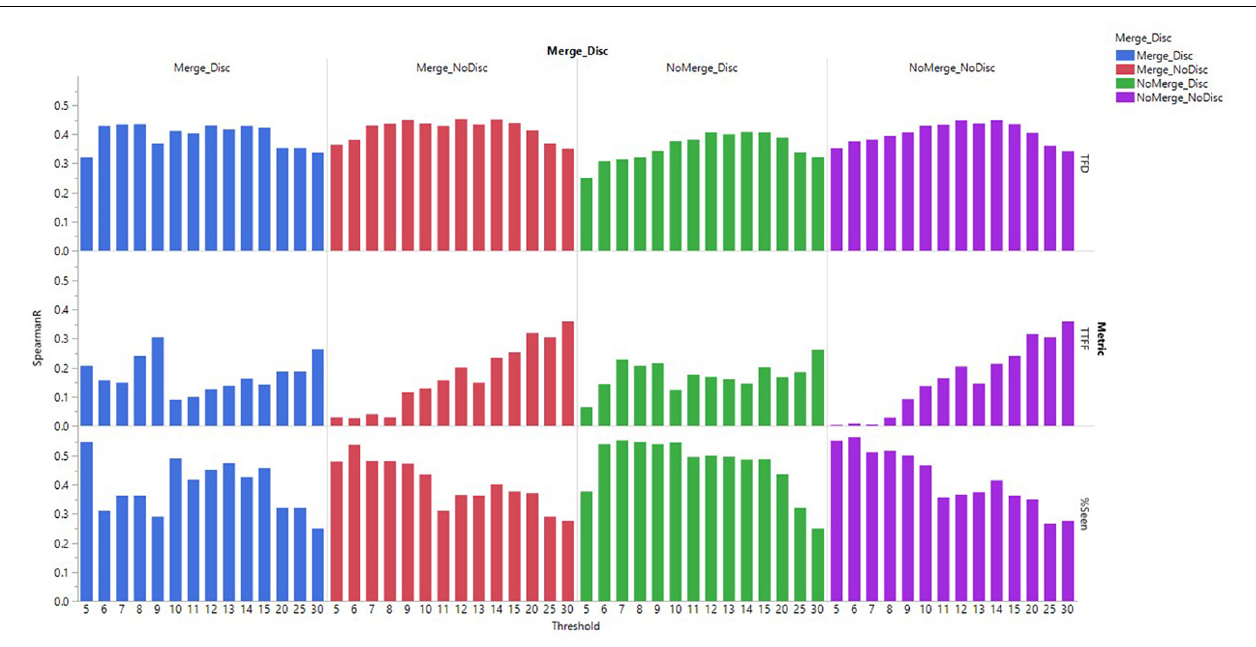
FIGURE 6 | The mean Spearman R scores across 1000 iterations of randomly split-half samples for different Test filters.